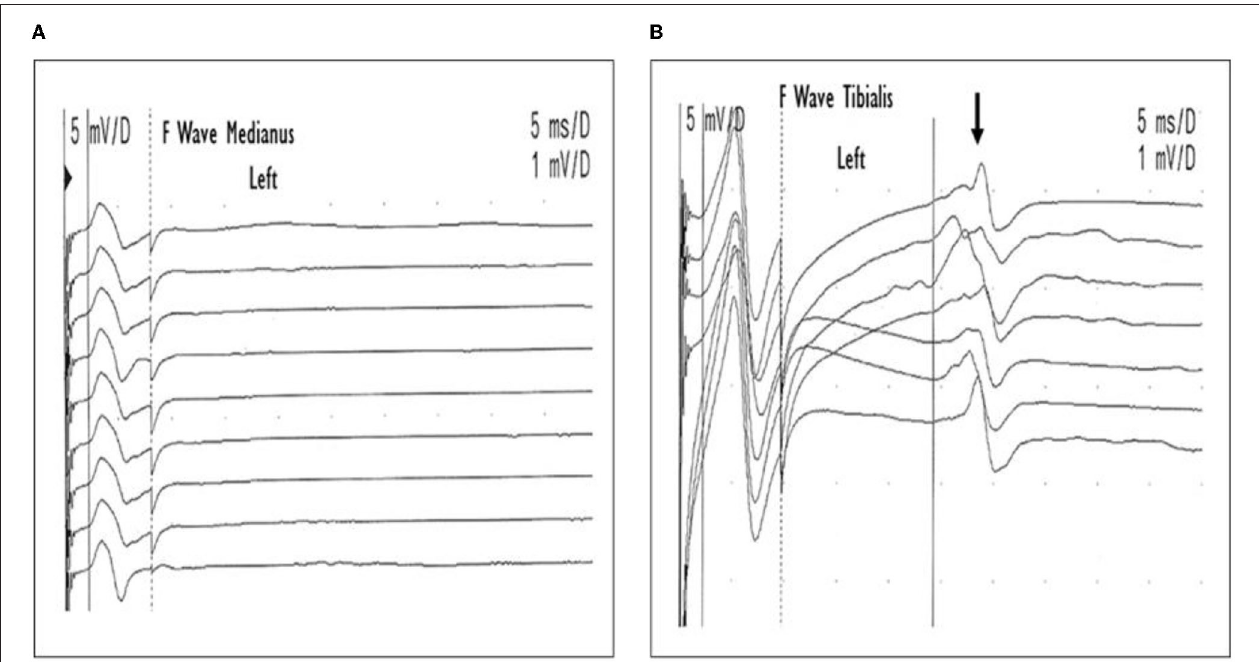
FIGURE 2 | Case 5. Pharyngo-cervical-brachial variant (PCBv). F wave performed in the 2nd week. Low amplitude CMAP and absence of F waves of the left median nerve (A) , and normal F waves (arrow) in the left tibial nerve (B) .